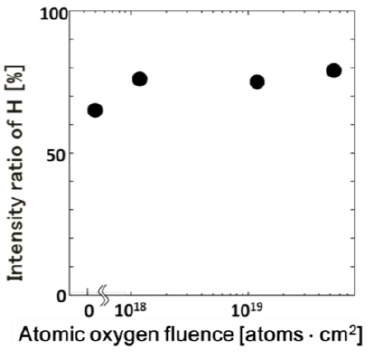
Figure 1. Dependence of film thickness determined from Rutherford backscattering spectrometry (RBS) of titanium-doped diamond-like carbon (Ti-DLC) films (red circles) and non-doped DLC films (blue circles) on atomic-oxygen fluence.